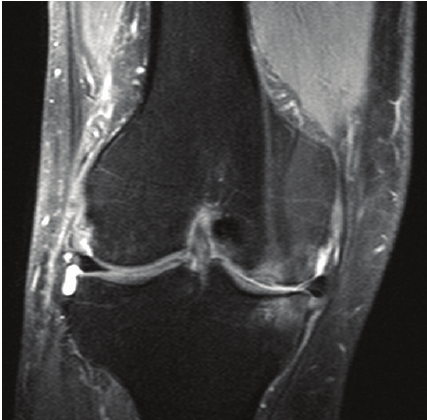
Figure 6: MRI of the knee: inflammatory changes with marked effusion and synovitis as well as subchondral edema at the medial tibia and the medial